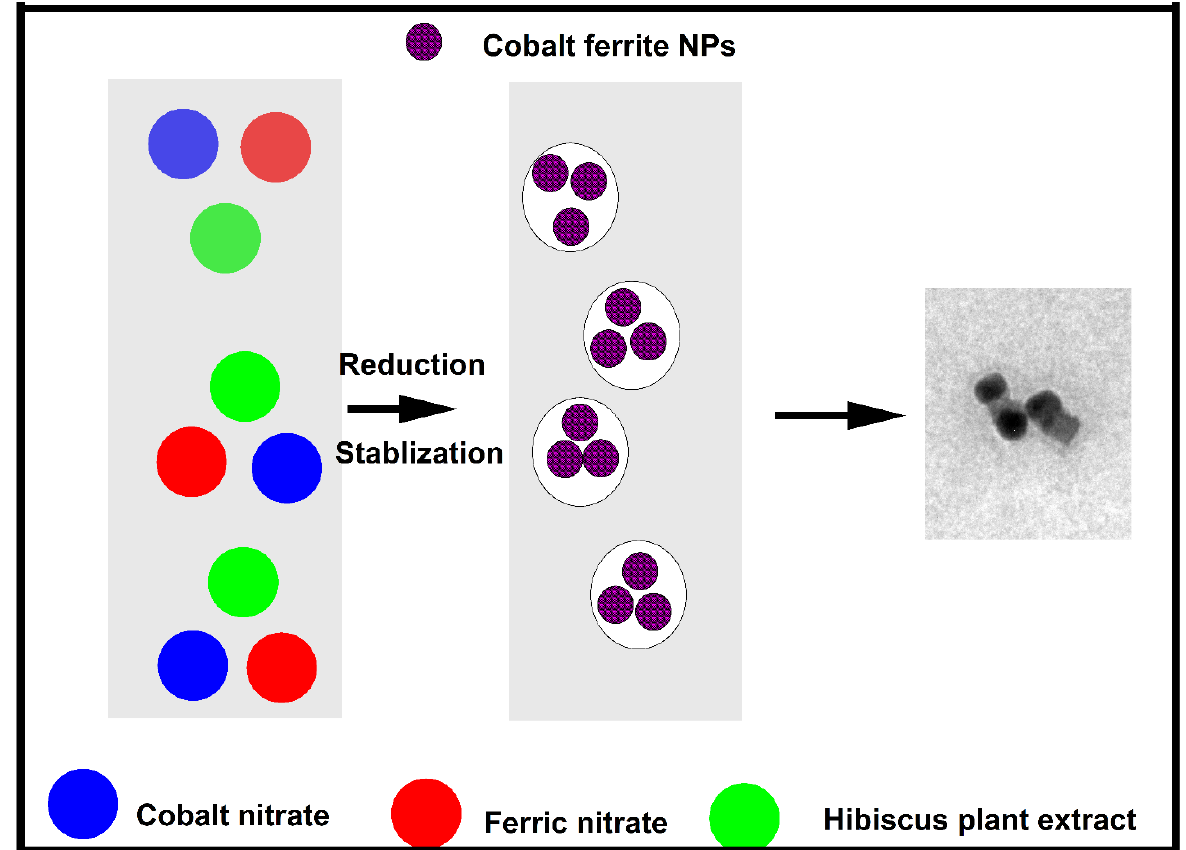
Figure 6. Nanostructure formation of biosynthesized CoFe 2 O 4 nanoparticles.